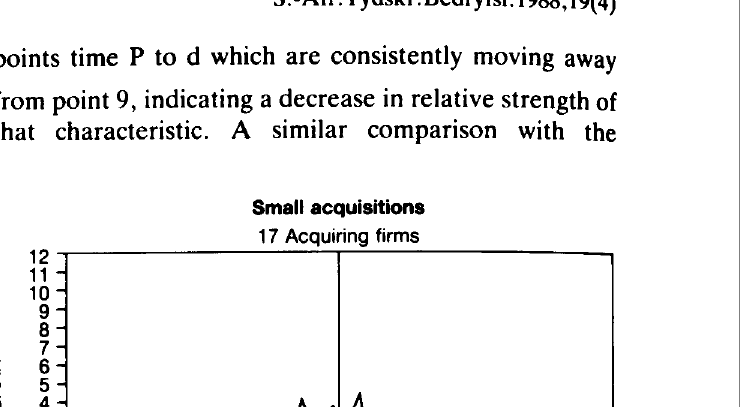
Figure 4 CAAR plot for relatively small acquiring firms